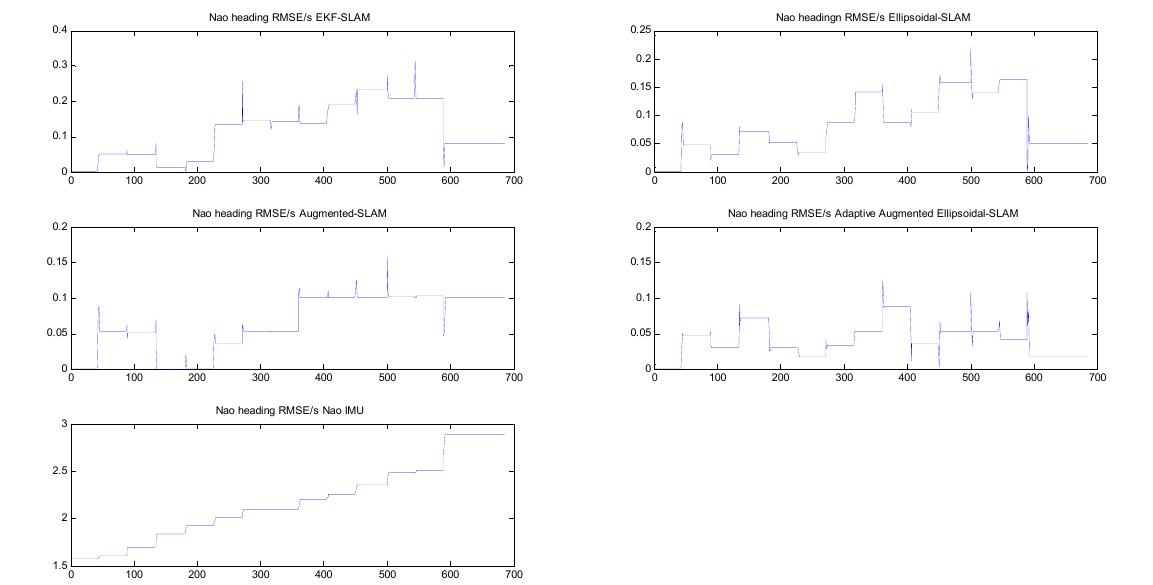
Figure 21. The RMS errors of the NAO heading of the implemented SLAM.